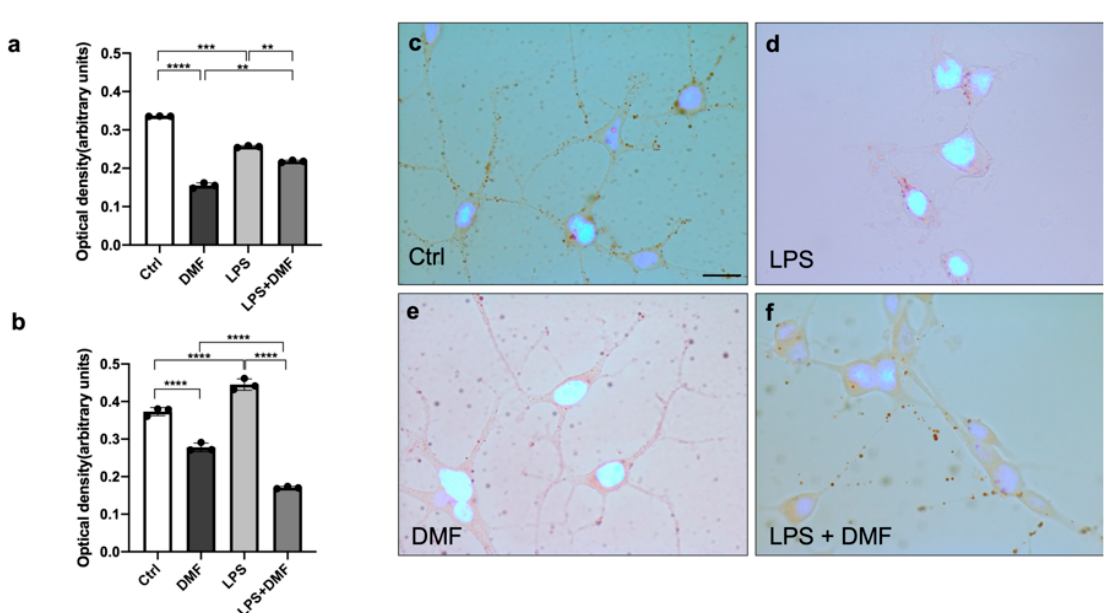
Figure 7. Lipid accumulation assay using Oil Red O staining. The graphs show the optical density relative to the number of LDs measured in the Oli neu cells in the following experimental conditions: untreated cells (Ctrl), LPS 1 μ g/mL, DMF 25 μ M and LPS 1 μ g/ μ L + DMF 25 μ M, after 48 h ( a ) and untreated cells (Ctrl), LPS 1 µ g/mL, DMF 25 µ M and LPS 1 µ g/ µ L + DMF 25 µ M, after 48 h ( a ) 120 h ( b ) of treatment. The data were obtained as the average ± SEM of three independent experi- ments performed in sextuplicate. One-way ANOVA test followed by the Turkey multiple compari- son post-test was used to statistically compare the different experimental conditions (** p < 0.01; *** p < 0.001; **** p < 0.0001). Representative images of Oli neu cells maintained for 48h in culture: vehi- cle-treated cells (Ctrl) ( c ), LPS 1 μ g/mL ( d ), DMF 25 μ M ( e ) and LPS 1 μ g/mL + DMF 25 μ M ( f ) treat- ments. Scale bar: 10 μ m.